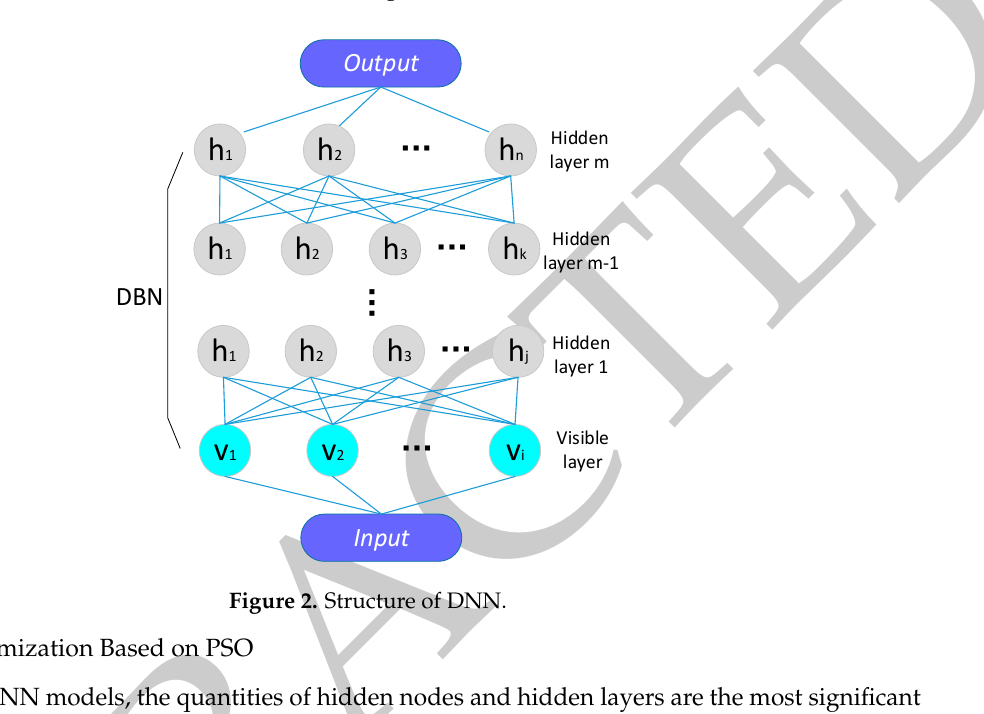
Figure 2. Structure of DNN.